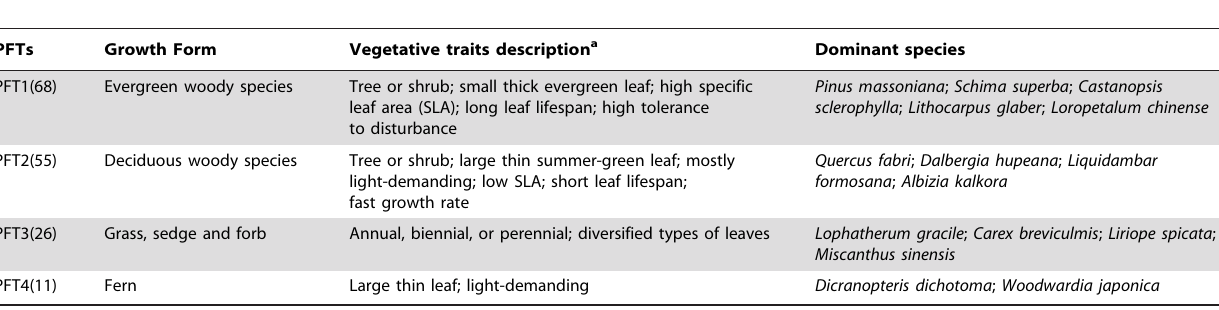
Table 3. Summary of characteristics of four plant functional types (PFTs) clustered by TWINSPAN on a set of 160 species (species richness of each PFT shown in parentheses).